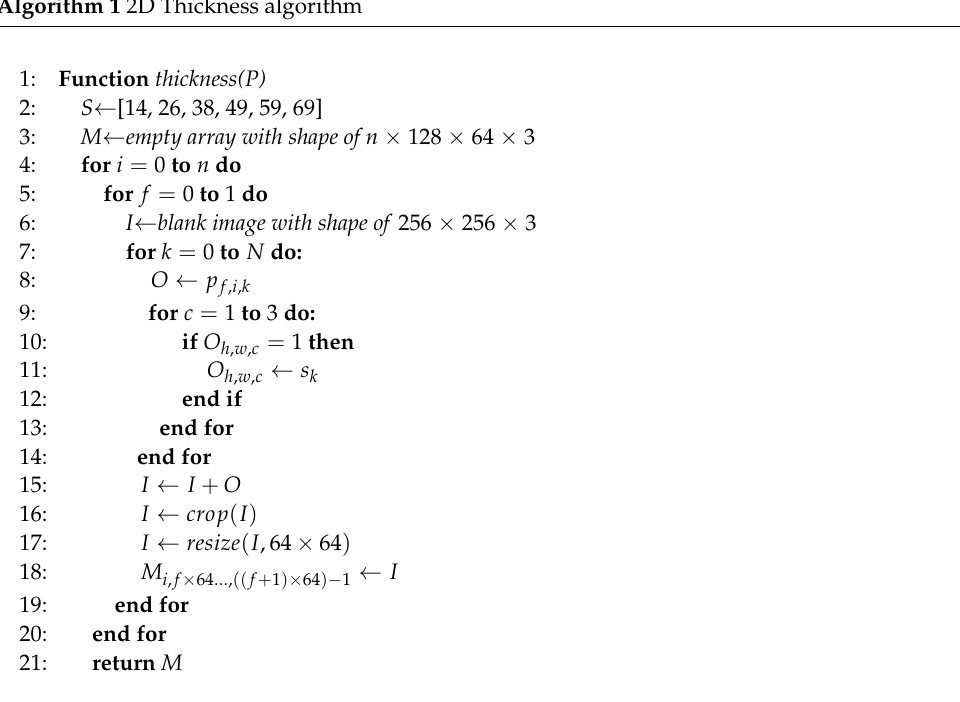
Algorithm 1 2D Thickness